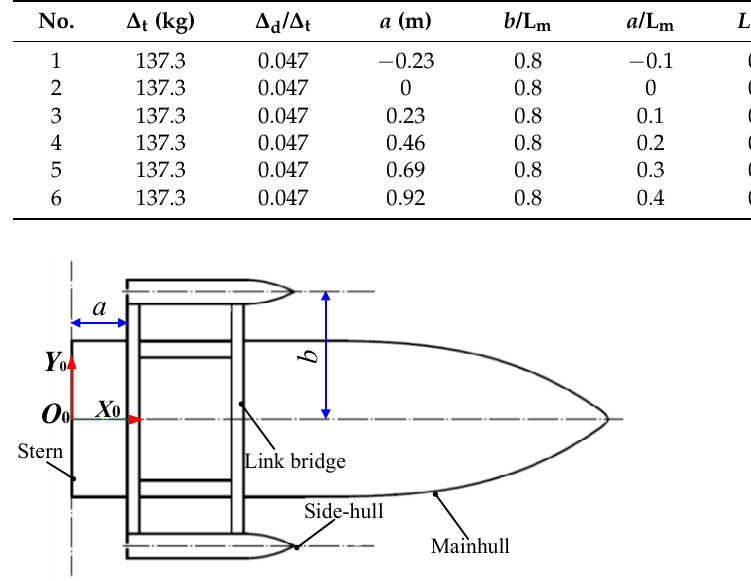
Figure 27. Longitudinal adjustment mode of the twin side ‐ hulls.